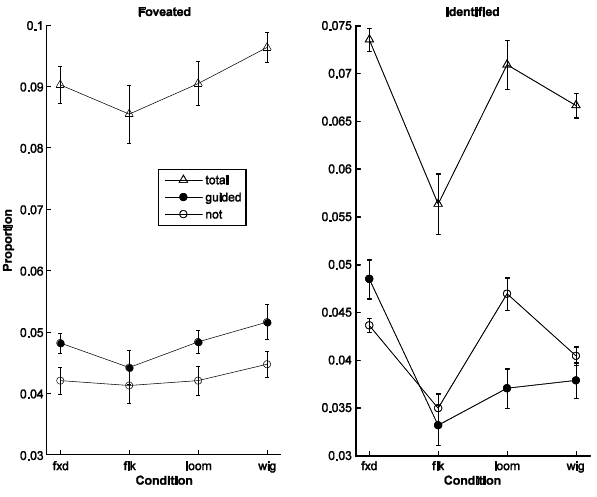
Figure 7. Letter foveation and identification rate for different markers (50% guidance; 100 ms gap). Left: Proportion of foveated (total, guided, not-guided). fxd: fixed amplitude (eccentricity-dependent marker without further modification); flk: flickering marker (alternating amplitude); loom: looming marker (gradual amplitude increase and decrease); wig: wiggly marker (alternating spatial displacement). Right: Proportion of identified letters (total, guided,